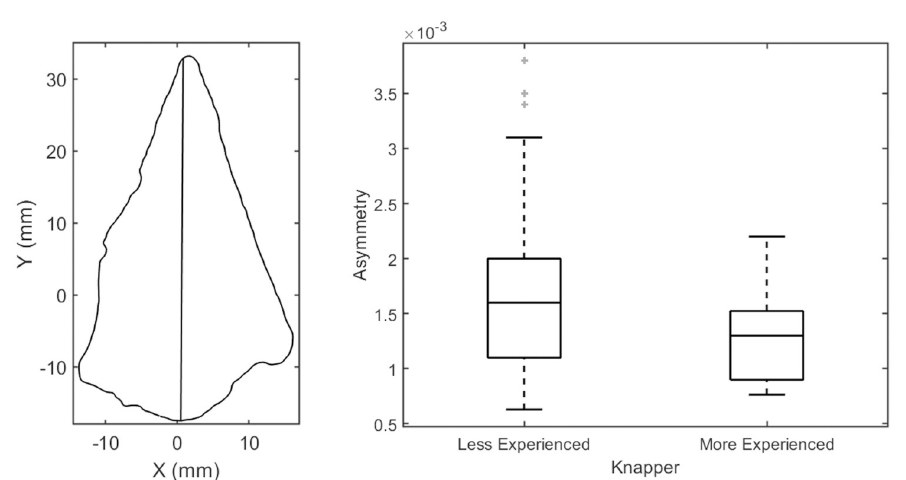
Fig 6. Plan view of the example Levallois flake with the line that separates the artifact outline into halves with the least amount of asymmetry (left), and a boxplot of the asymmetry values for the less and more experienced knappers